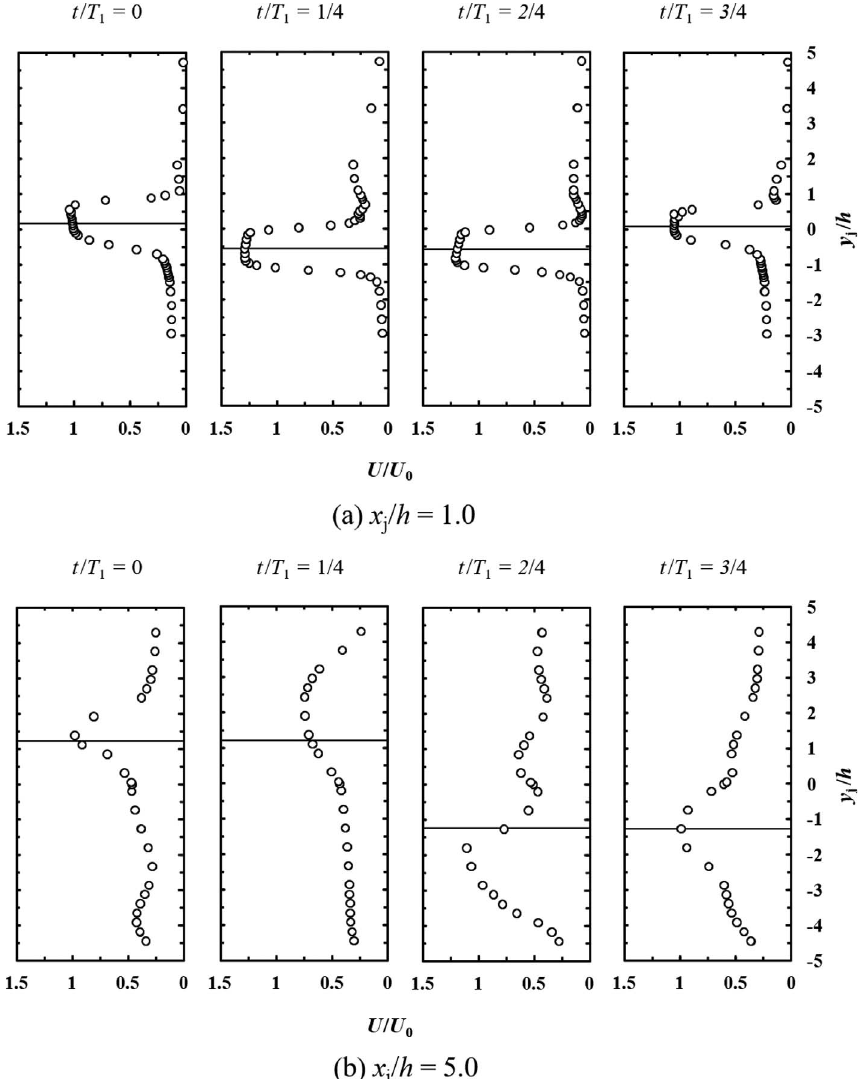
Figure 14. Periodical variations of velocity pro fi les, where lines show jet displacements ( y d ). ( h j = 39 (cid:3) , y j,e = 0, l / h = 5.6, Q = 16